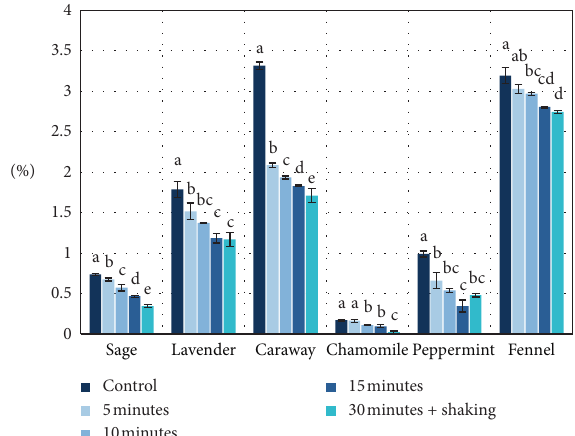
Figure 6: Content of essential oil in the postbrewing (after primary brewing) plant material (% v / w ). Control—content of essential oil in the primary material. Data are shown as mean ± SD. Different letters (a, b, c, etc.) show a significant difference with p < 0 .